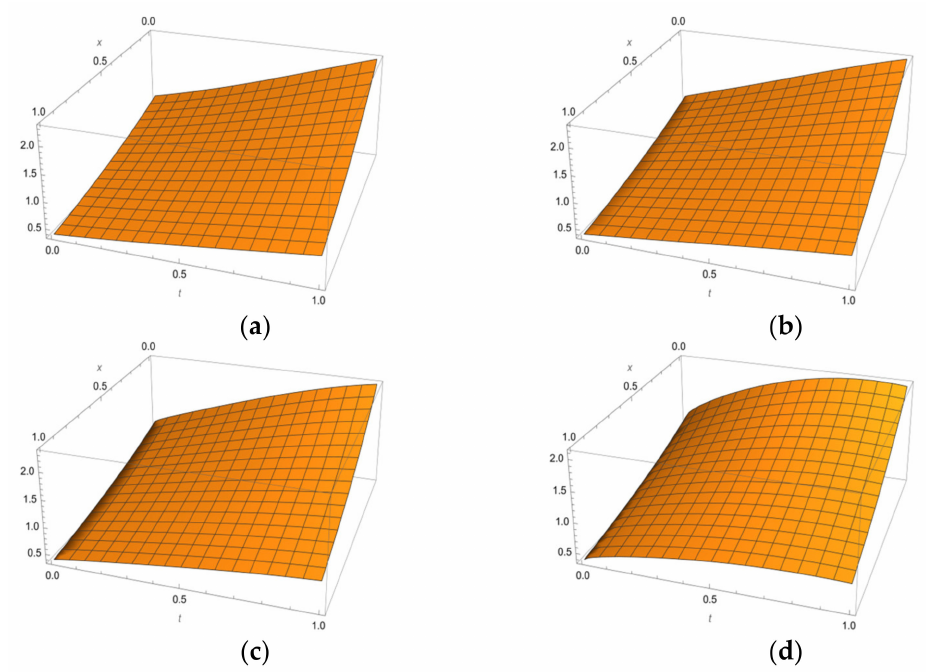
Figure 1. The 3D graph and the contour of the solution f ( x , t ) of the fractional equation of the cancer tumor model at r = − 1.2 and several values of α in Example 1. ( a ) α = 1; ( b ) α = 0.9; ( c ) α = 0.8; ( d ) α =